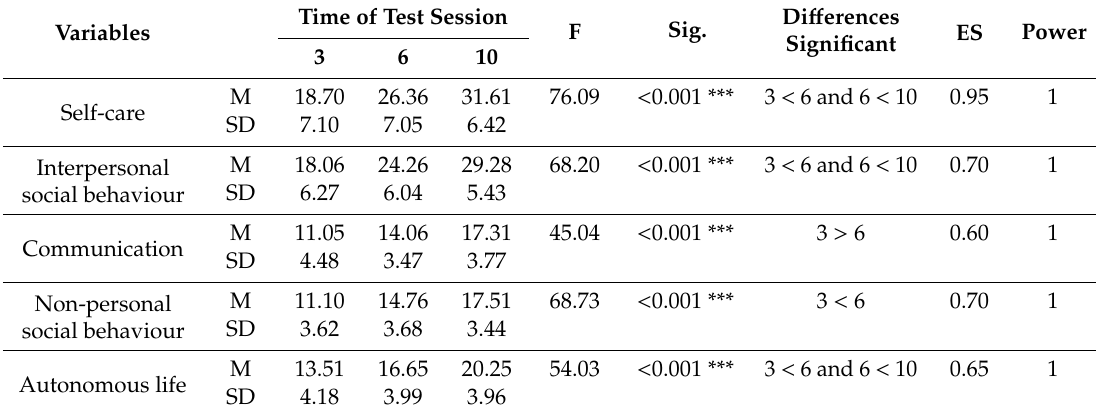
Table 3. Results of everyday life skills (LSP).